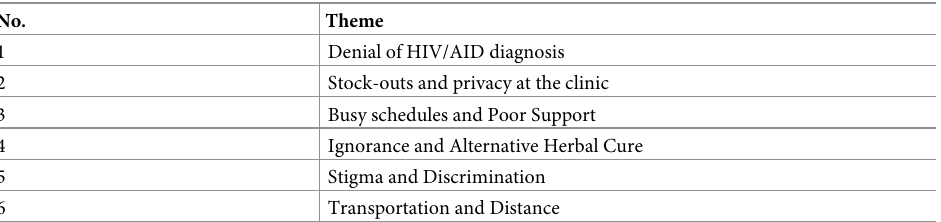
Table 3. Summary of